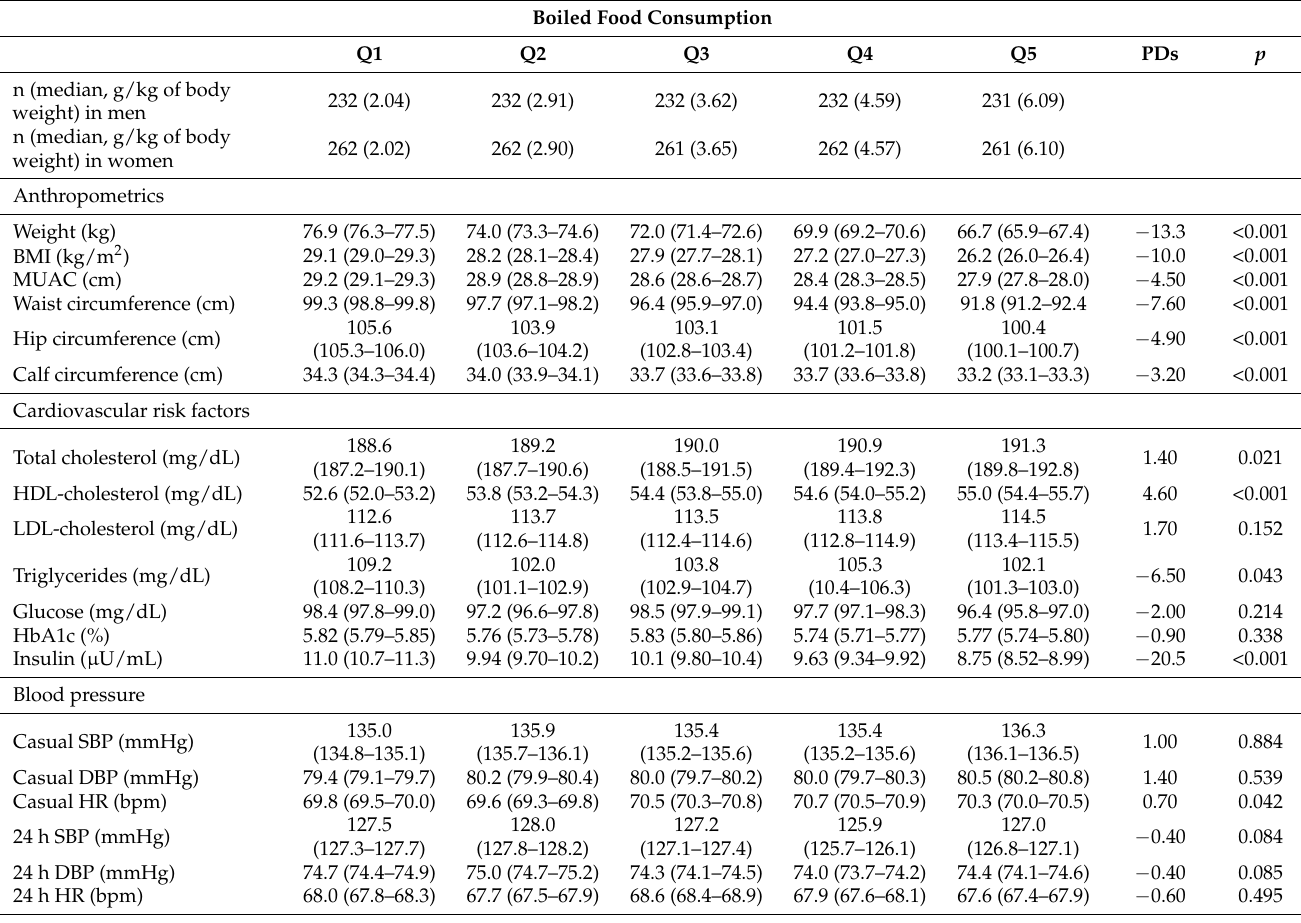
Table 3. Adjusted means (95% confidence interval), percentage difference, and p for a linear trend across quintiles of boiled food